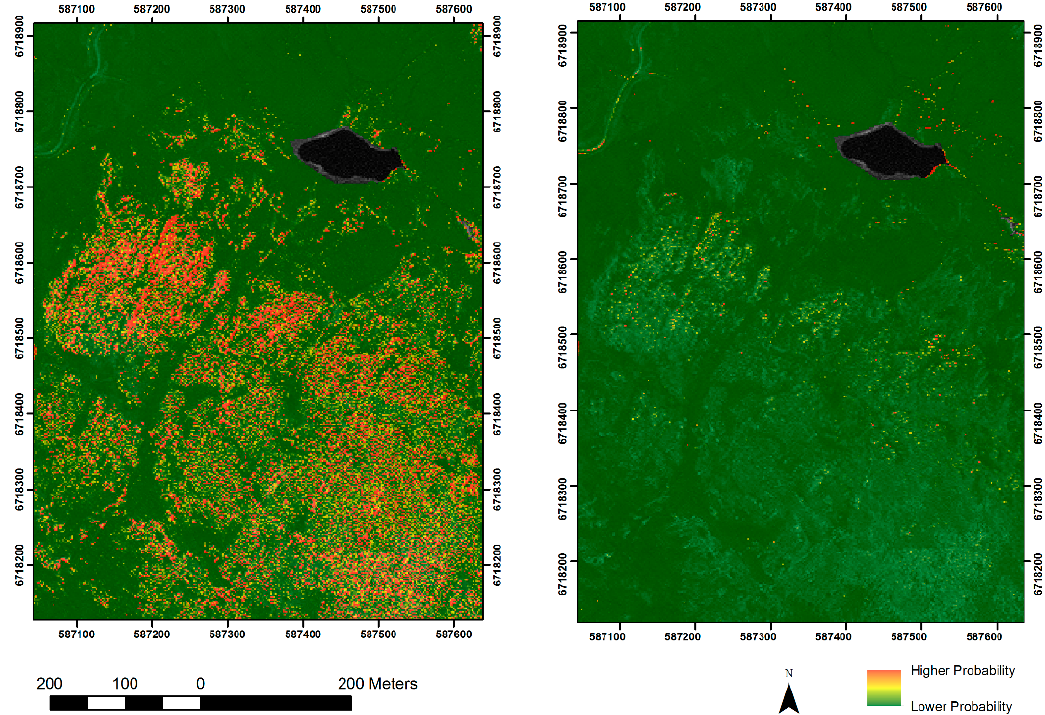
Figure 7. The effects of principal components analysis on 8 Worldview-2 bands, showing workshops at the Beorgs of Uyea.